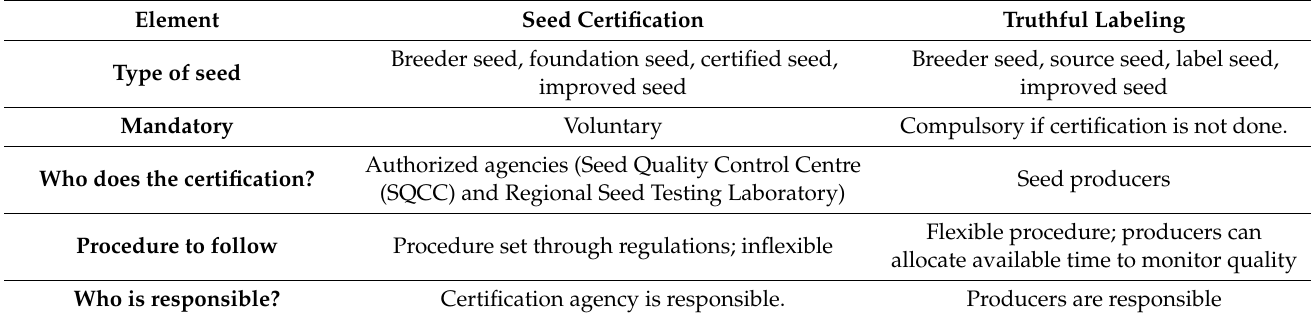
Table 3. Comparison between seed certification and truthful labeling in Nepal